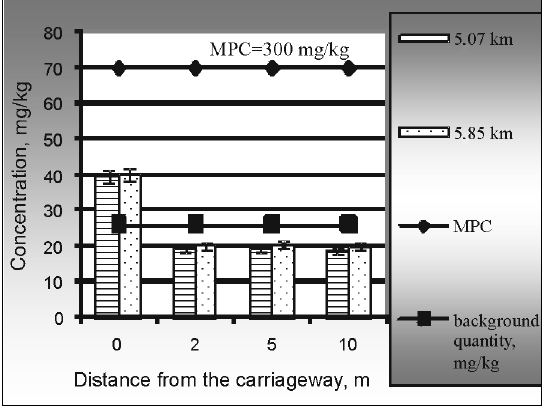
Fig. 10. Zinc concentration in the roadside soil of the gravel